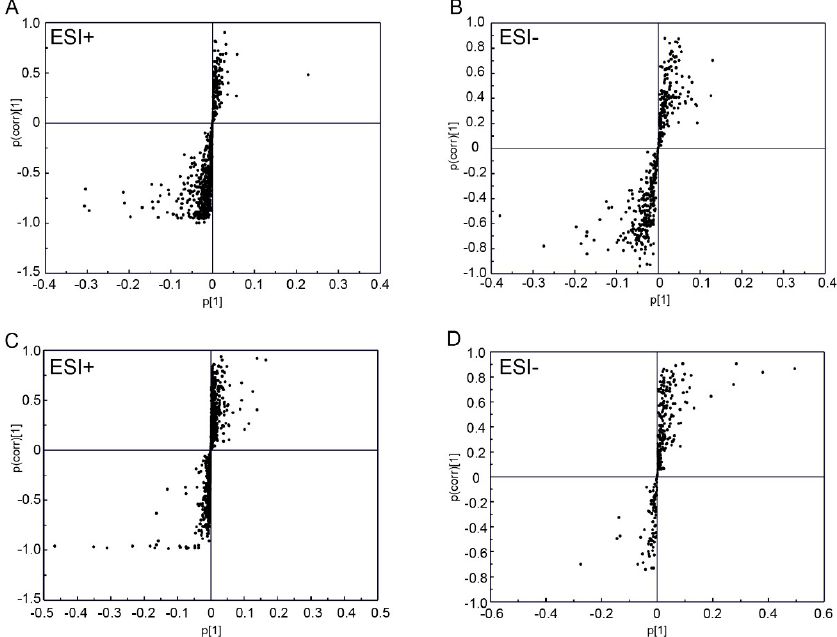
Figure 3. S-plot from OPLS-DA analysis. ( A – B ) 1 day group; ( C – D ) 3 day group.